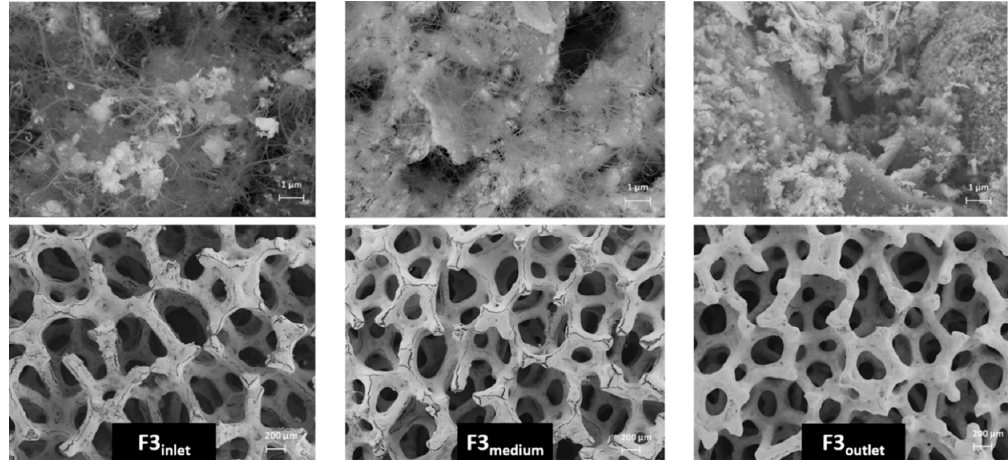
Figure 9. SEM micrographs of the three portions of F3 catalyst: F3 inlet , F3 medium , and F3 outlet , after DRM.